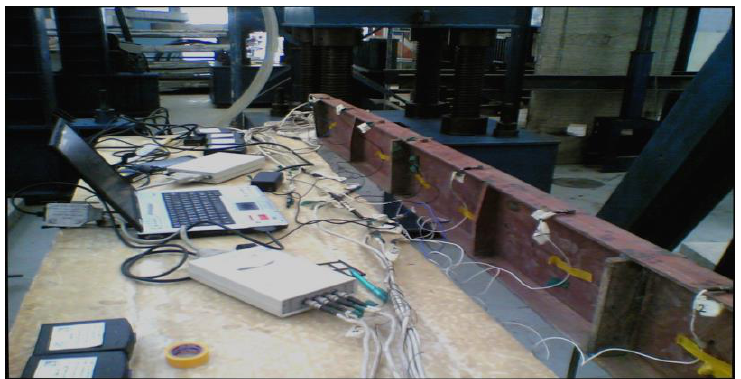
Figure 2. Multi-channel digital data acquisition system and arrangement of accelerometers on the top flange of the beam.